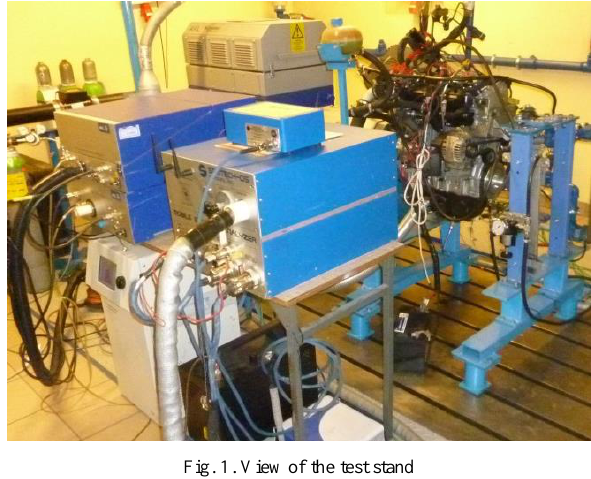
Glow plugs with catalyst, no heating Glow plugs with catalyst, heating 60 s after engine cold start Glow plugs with catalyst, heating 60 s prior to and after engine cold